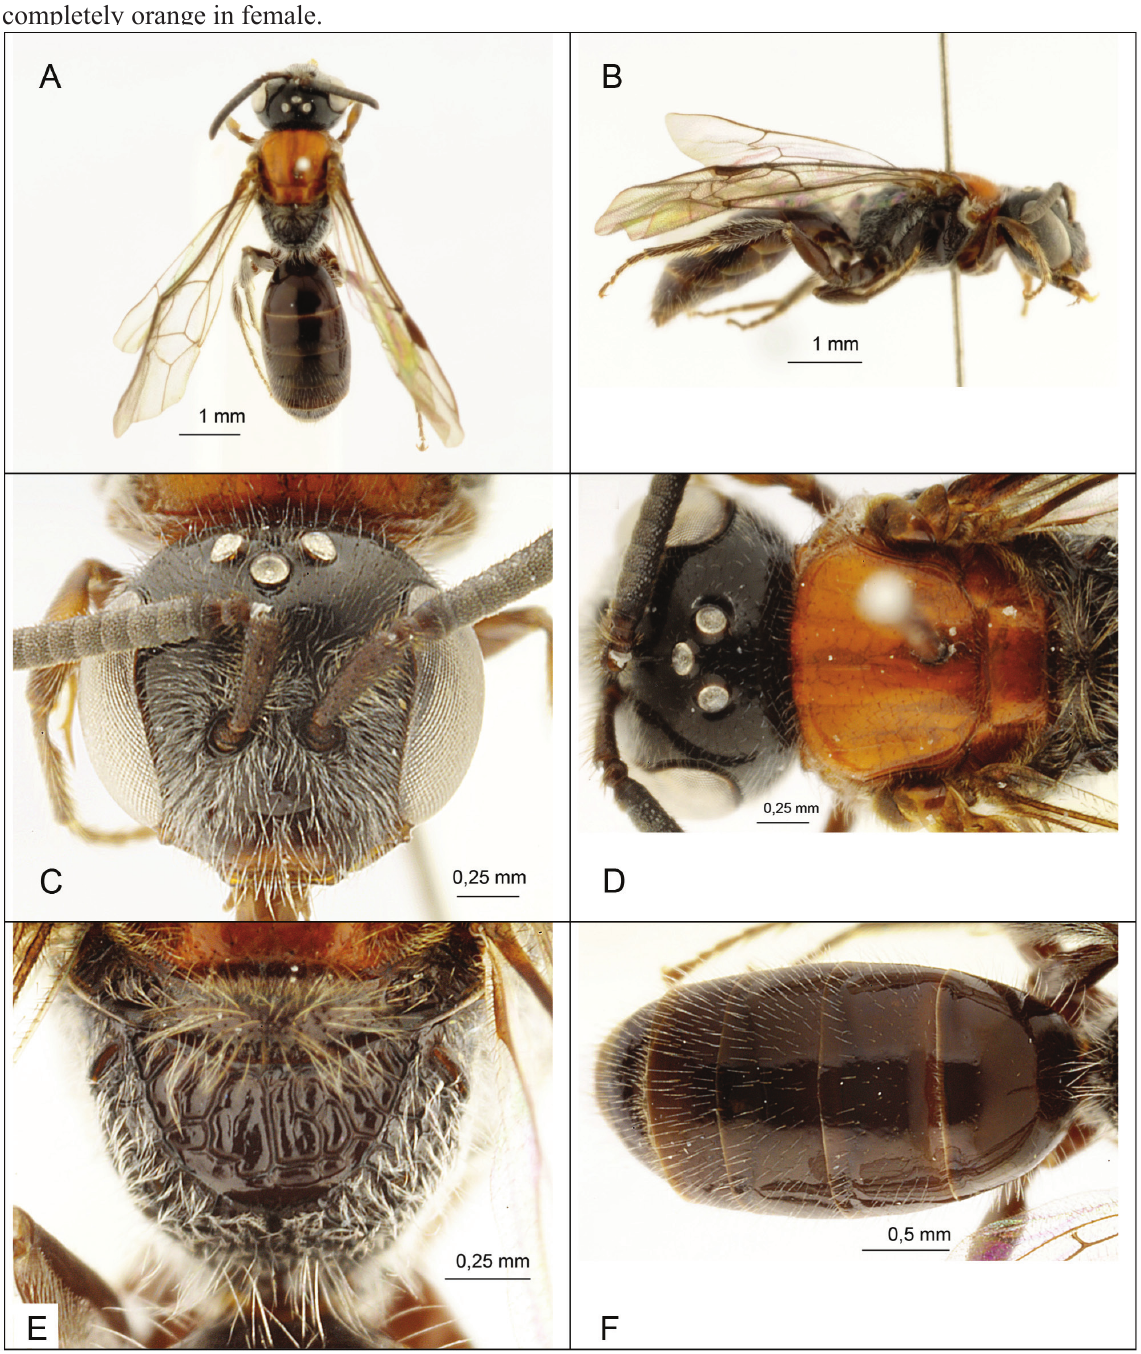
Fig. 4. Eupetersia yanegai sp. nov., ♂ holotype. A . Dorsal view of habitus. B . Lateral habitus. C . head, facial view. D . Mesosoma and head. E . Propodeaum. F .